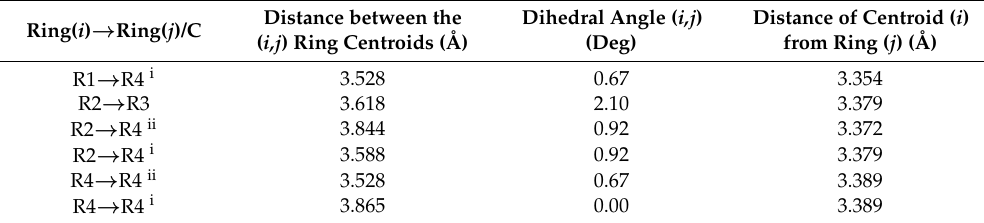
Table 2. π - π interactions (face-to-face) in complex ( 1 ) a